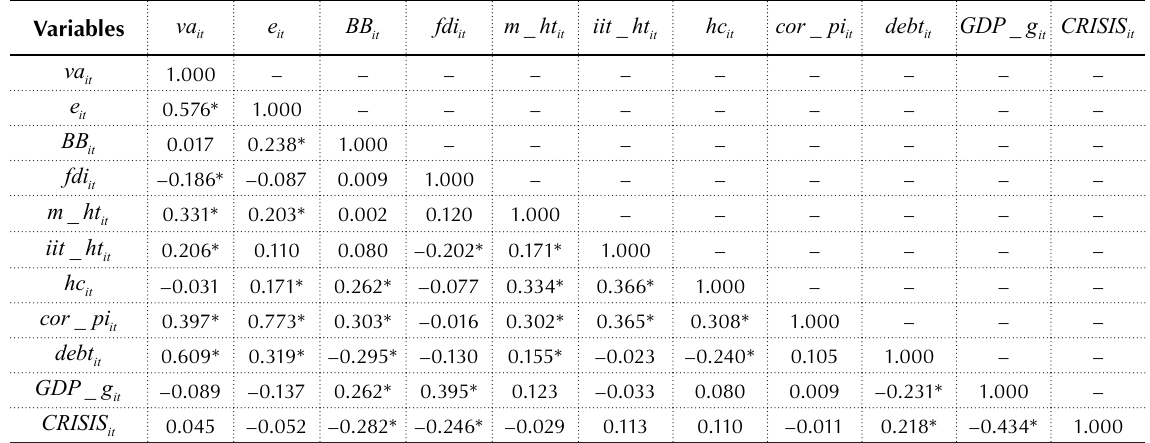
Table 4. Correlations for the whole sample of European economies Source: Authors’ calculations based on data from the sources mentioned in Table